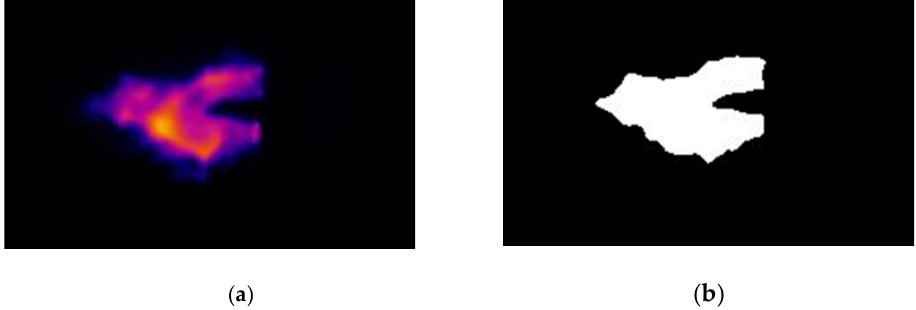
Figure 11. Procedure of determining the initial flame area: ( a ) Raw infrared image; ( b ) Binary image.